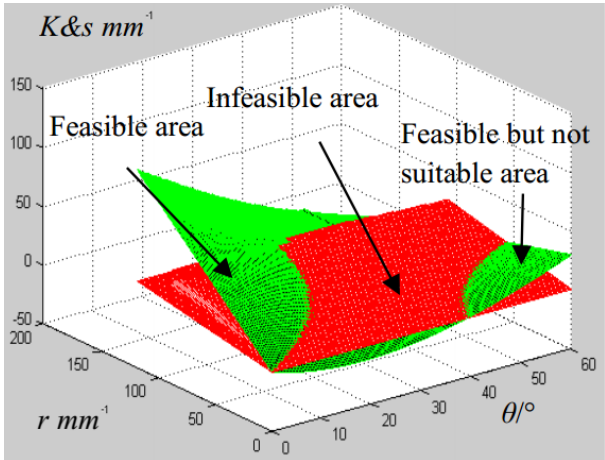
Figure 13. Remaining kinematic margin ( F 1 L 1 ) of leg 1 after trunk twisting.